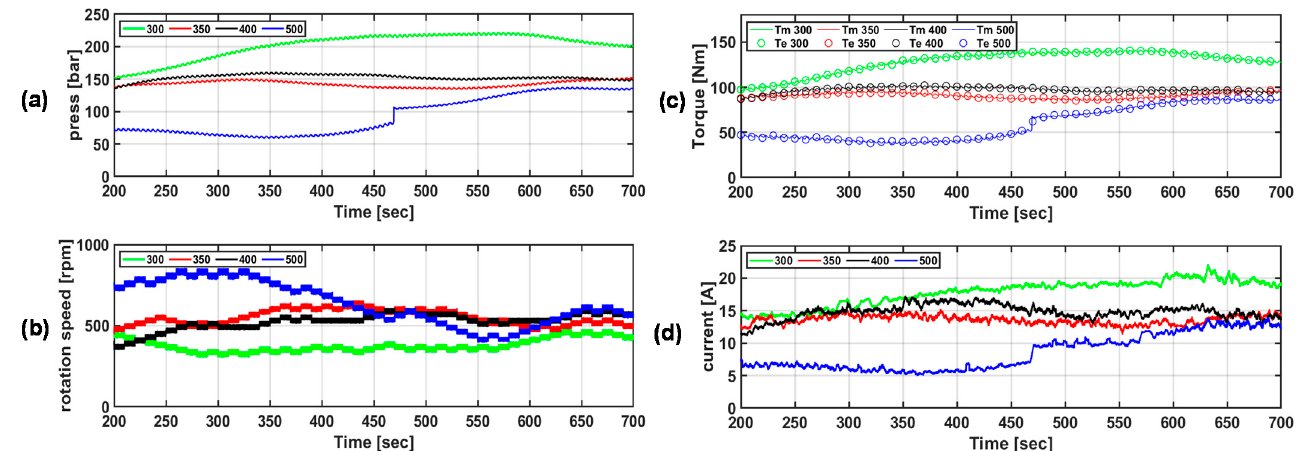
Figure 11. ( a ) Pressure in the circuit, ( b ) hydraulic motor rpm, ( c ) mechanical and electrical torques, and ( d ) load current according to the initial reference rpm of the speed control algorithm under regular wave conditions (legend indicates initial rpm).